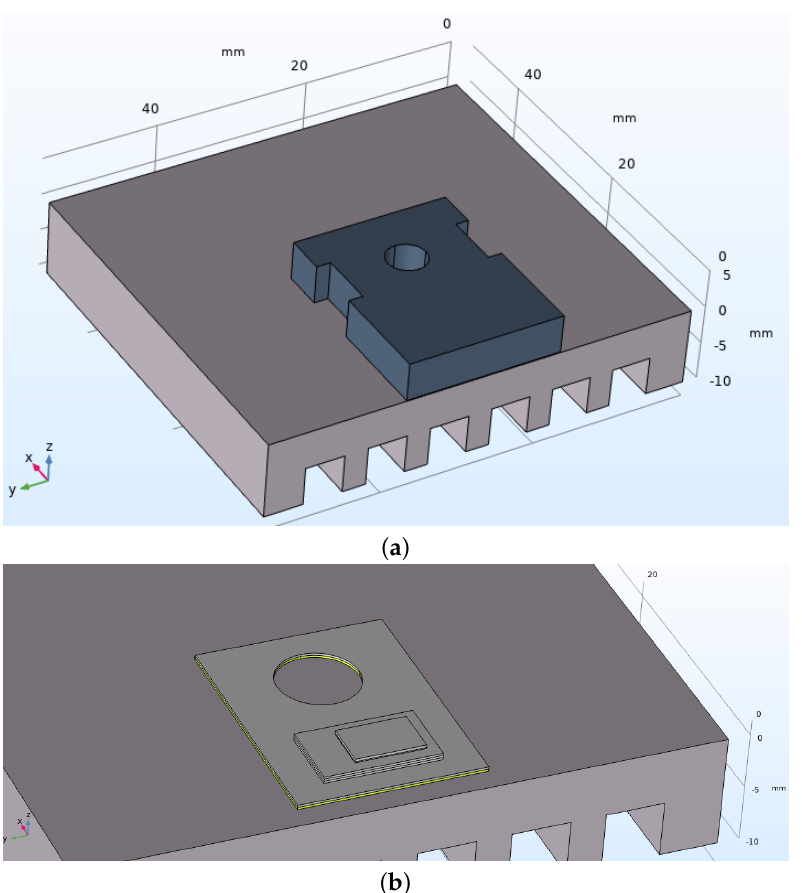
Figure 11. 3D simulated structure of case study IGBT switch in COMSOL; ( a ) overall structure with packaging, and ( b ) internal structure of the switch with layered structure.